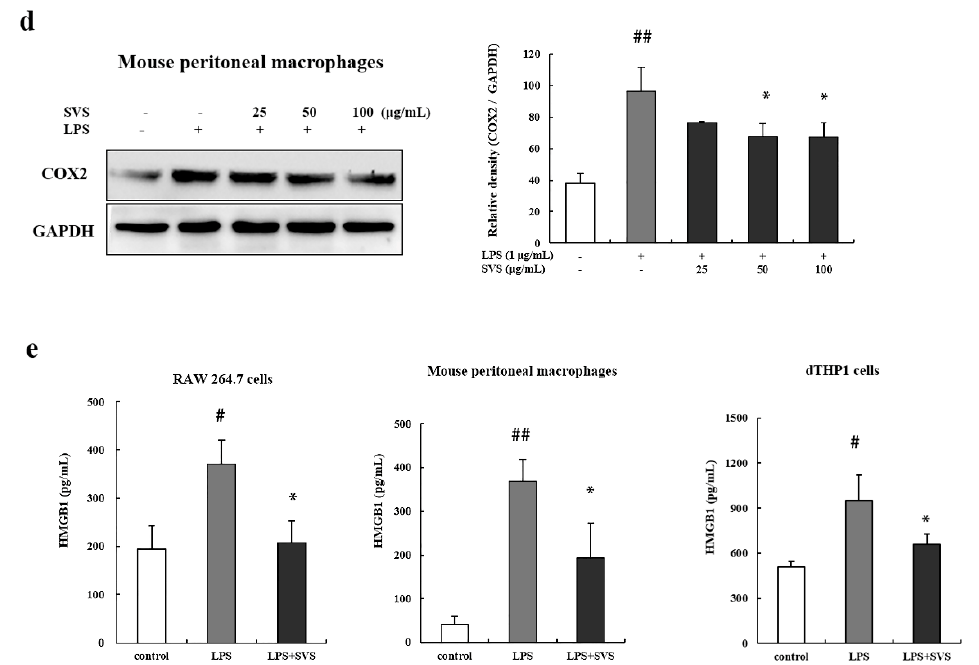
Figure 4. Stevioside suppressed LPS-induced iNOS, COX-2, and HMGB1 expression in macrophages. ( a , b ) Macrophages were pretreated with or without stevioside (100 µ g/mL) for 1 h and then stimulated with LPS (1 µ g/mL) for another 9 h. Transcripts of iNOS were examined by RT-PCR ( a ) or RT-qPCR ( b ) in macrophages; ( c ) Macrophages were pretreated with or without stevioside (100 µ g/mL) for 1 h and then stimulated with LPS (1 µ g/mL) for another 24 h. The production of NO was detected by the Griess reaction in the culture medium; ( d ) Macrophages were pretreated with or without stevioside (25, 50, or 100 µ g/mL) for 1 h and then stimulated with LPS (1 µ g/mL) for another 4 h. COX-2 protein was detected by Western blot in cell lysates. GAPDH was used as an internal control; ( e ) Macrophages were treated as in ( c ). HMGB1 level was determined by ELISA in the culture medium; # p < 0.05, ## p < 0.01, ### p < 0.001 versus control group; * p < 0.05, ** p < 0.01 versus LPS-treated group. SVS, stevioside.